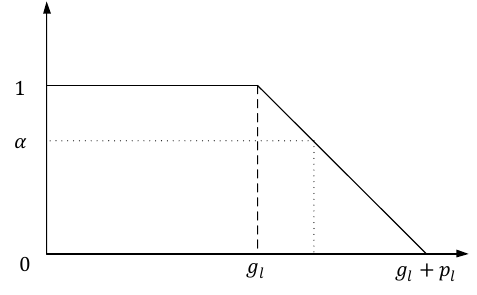
Fig.1. Membership Function Related to